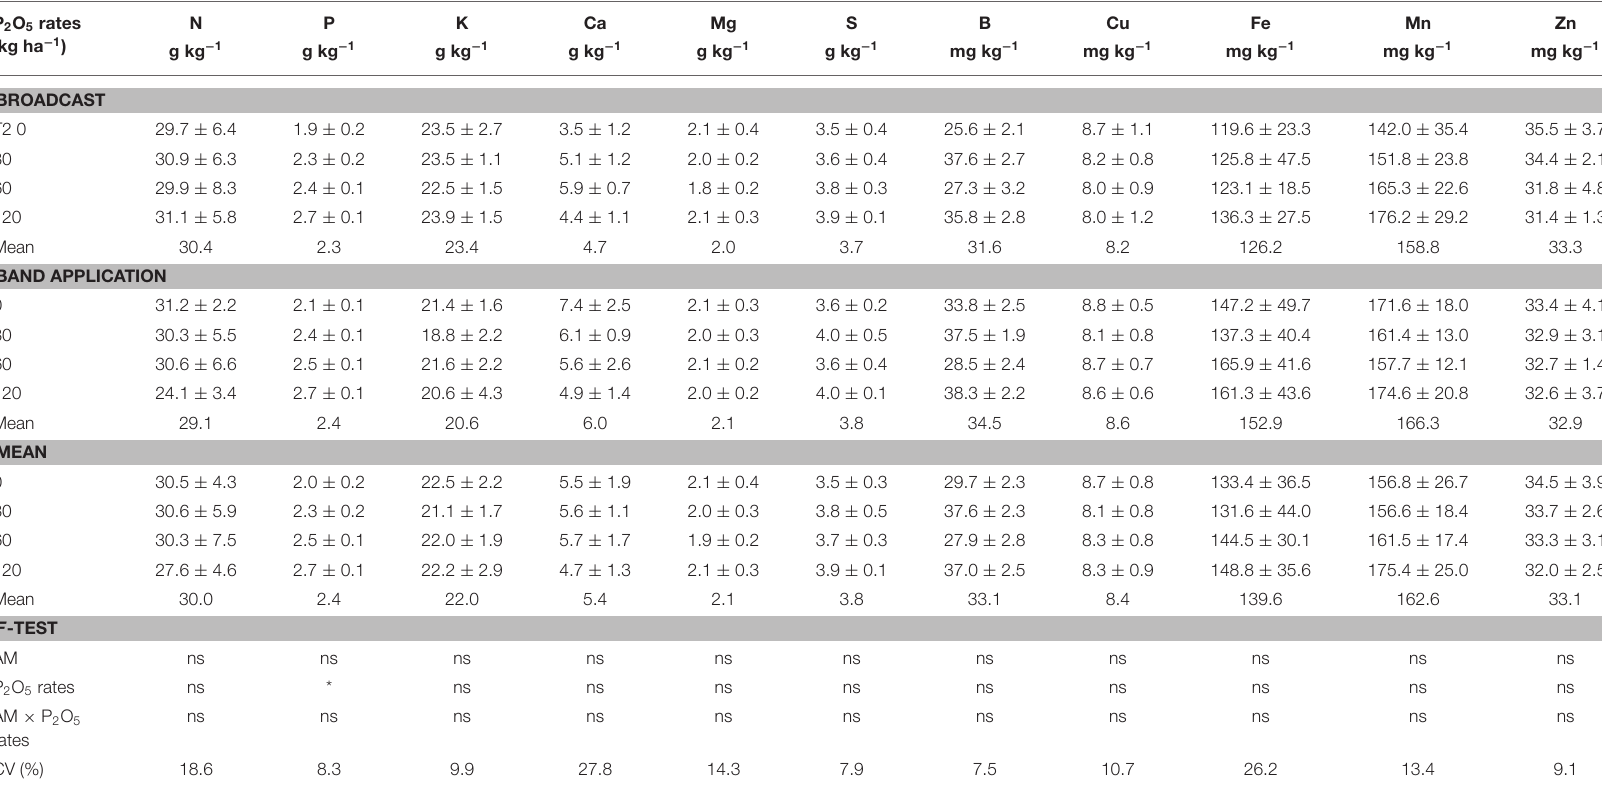
TABLE 4 | Leaf N, P, K, Ca, Mg, S, B, Cu, Fe, Mn, and Zn concentrations as influenced by the P 2 O 5 rates, with two application methods (AM) (broadcast or band application), on the average of two growing seasons of wheat crops, Londrina, Paraná State,